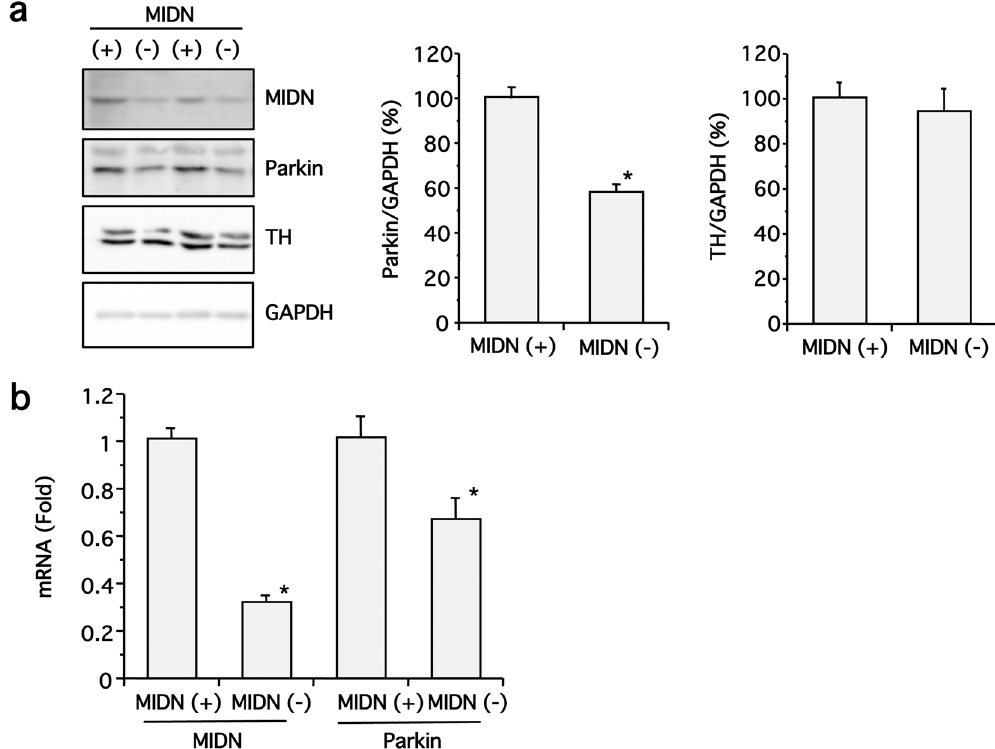
Figure 5. MIDN is necessary for parkin expression in PC12 cells. ( a ) MIDN, parkin, TH, and GAPDH protein levels in MIDN-positive and -negative PC12 cells were examined by Western blotting (left panel). The density of the parkin and TH bands was normalized to that of GAPDH, and these ratios were expressed as a percentage of MIDN-positive cells (middle and right panels). Parkin protein expression was significantly inhibited by MIDN knockout ( * p < 0.05, n = 6) whereas TH protein expression was not significantly changed (n = 6). (b) Gene expression levels of MIDN and parkin in MIDN-positive and -negative PC12 cells were examined by qRT-PCR. Significant differences in both MIDN and parkin gene expression were observed between MIDN-positive and -negative cells ( * p < 0.05, n =